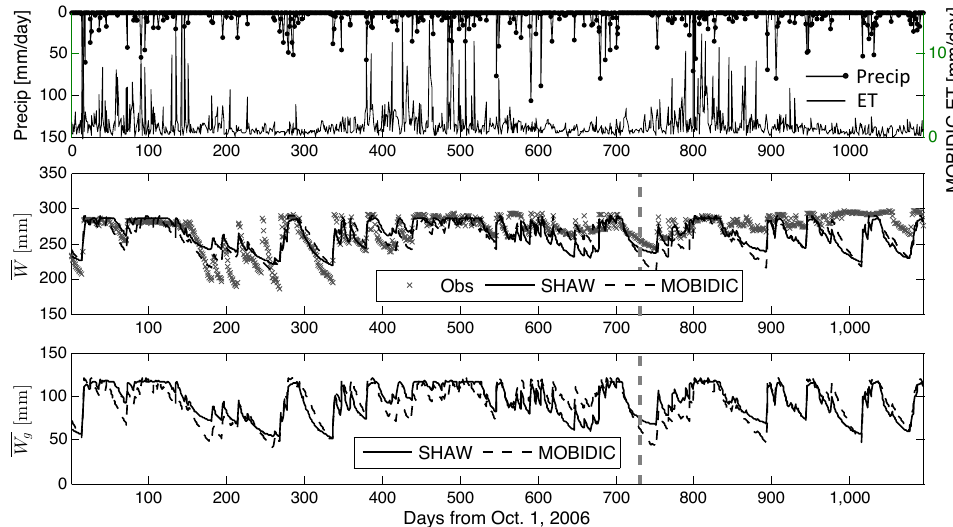
Figure 6. Site 2: (a) observed precipitation [mmday − 1 ] and MOBIDIC-simulated ET [mmday − 1 ]; (b) observed, SHAW-, and MOBIDIC- simulated equivalent depth [mm] of soil water stored in the top 50cm; and (c) MOBIDIC- and SHAW-simulated equivalent depth [mm] of water in the capillary reservoir of the top 50cm of